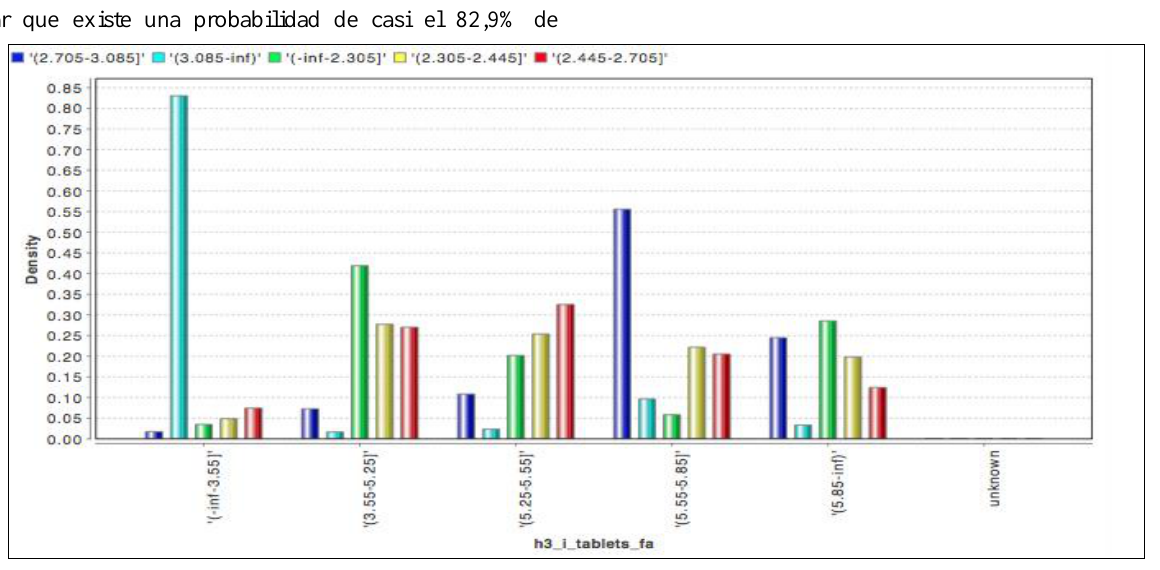
Figura 8. Densidad de probabilidad de intervalos discretos de THDv en relación con la corriente del 3º armónico. La figura. 9 Muestra la densidad de probabilidad de ocurrencia de cinco intervalos discretos del THDv en